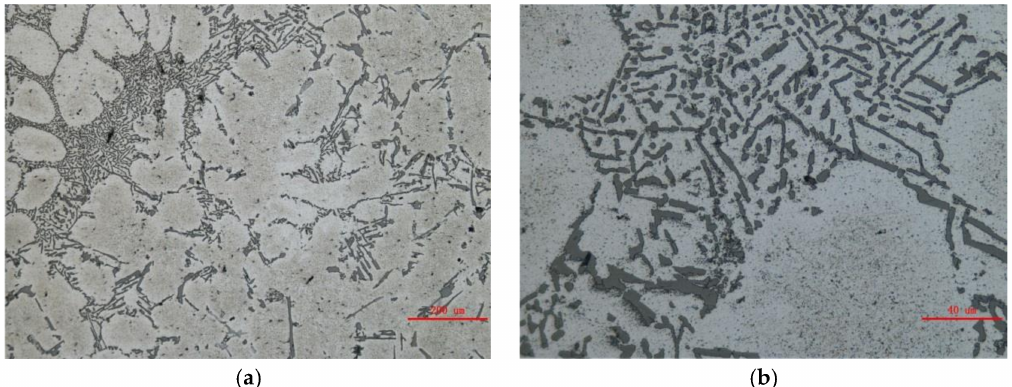
Figure 13. Microstructure of the casting by the lattice sand mold: ( a ) 100 × ; and ( b ) 500 ×